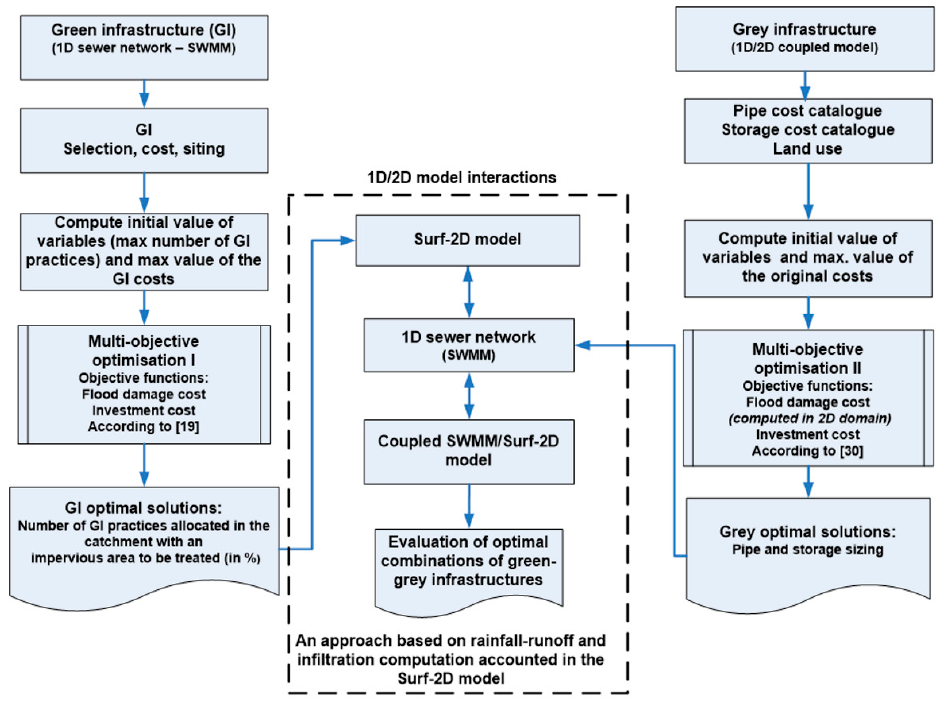
Figure 2. Structure of the proposed multi-objective model-based assessment.